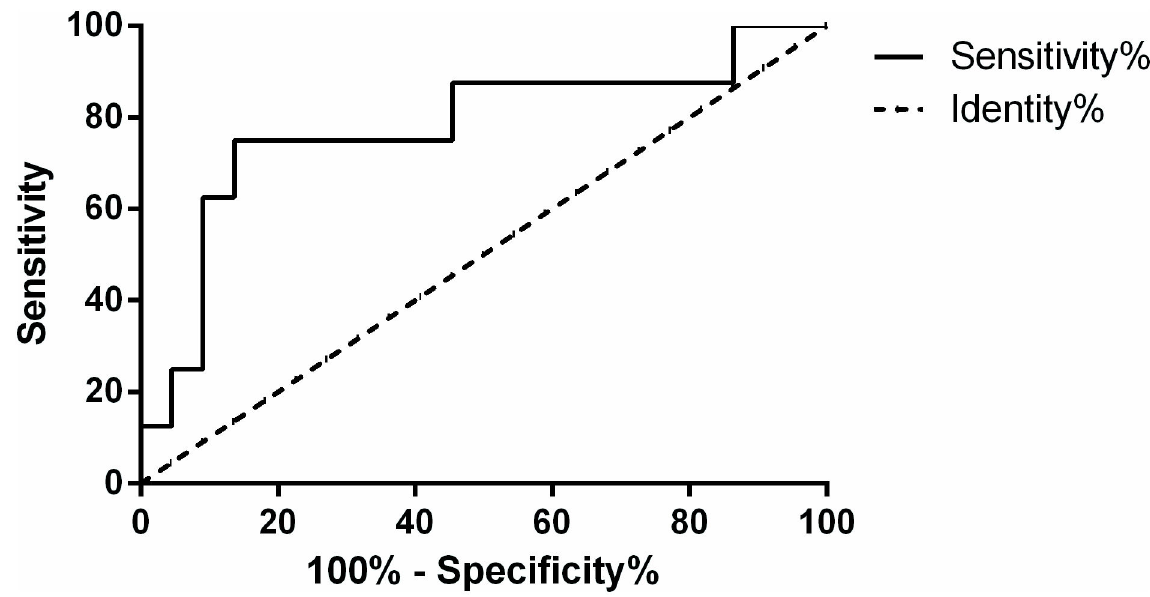
Figure 4. ROC curve with AUC for urine NAG to creatinine ratio at the time of diagnosis.